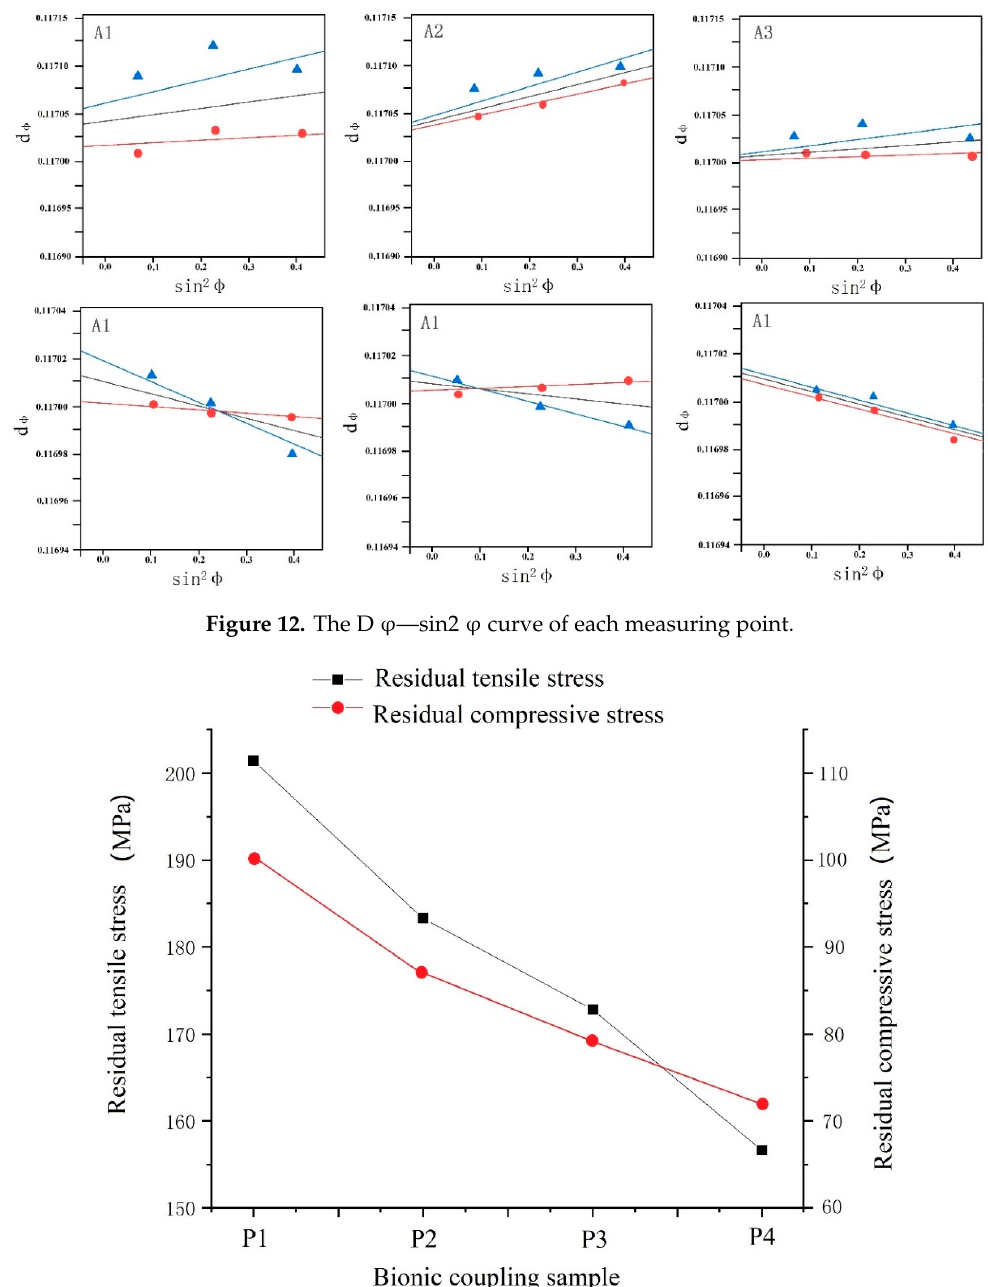
Figure 14. Microstructure of the cross sections of specimen after thermal 600 cycles. ( a ) the substrate; ( b ) the bionic unit